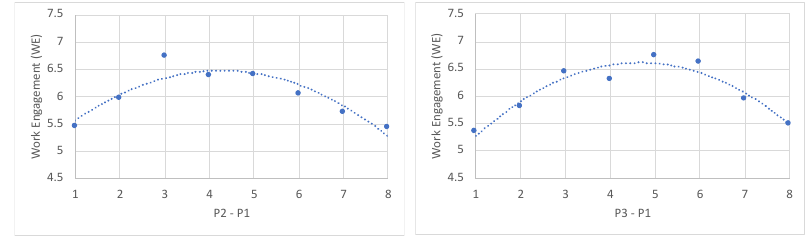
Figure 2. Relative performance as an independent variable and work engagement as a dependent